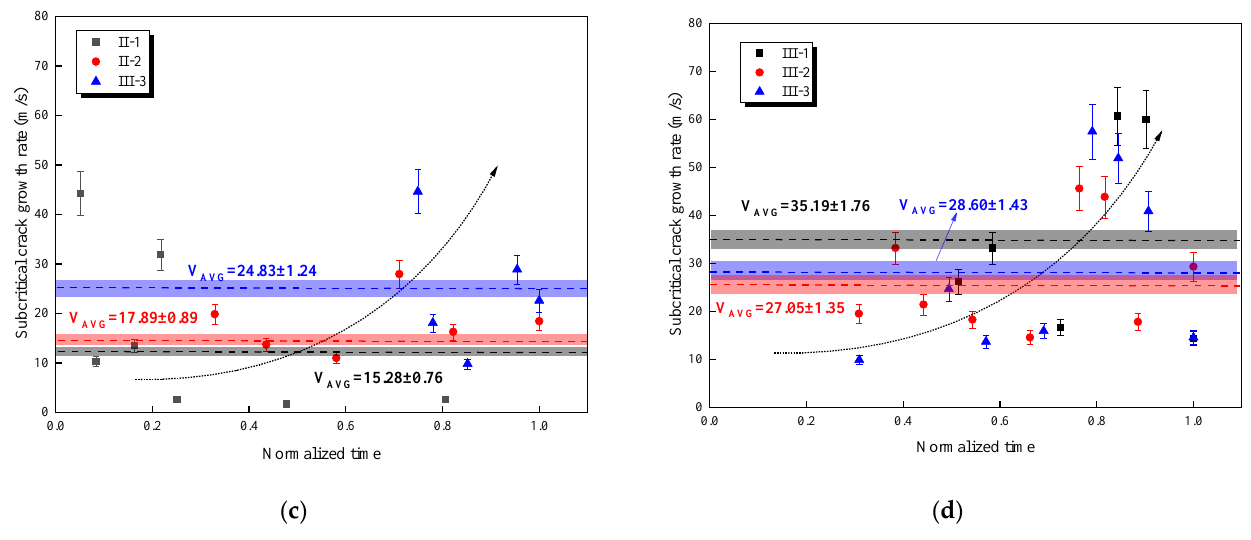
Figure 11. The voltage signal and subcritical crack growth rate. ( a ) Variation of CPG voltage signal during the whole process for specimen ANSCB − II − 1, ( b ) the subcritical crack growth rate of ANSCB − I, ( c ) the subcritical crack growth rate of ANSCB − II, and ( d ) the subcritical crack growth rate of ANSCB-III.